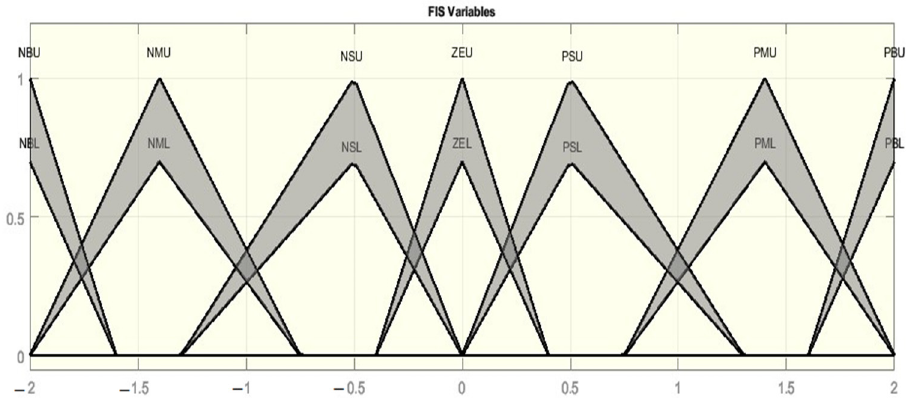
Figure 5. FIS variables of change in power (P).